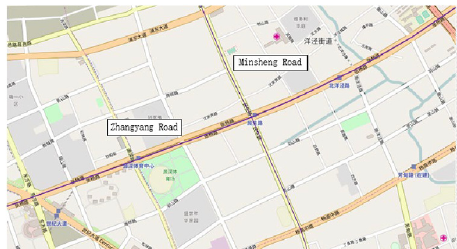
Figure 4 Actual road network